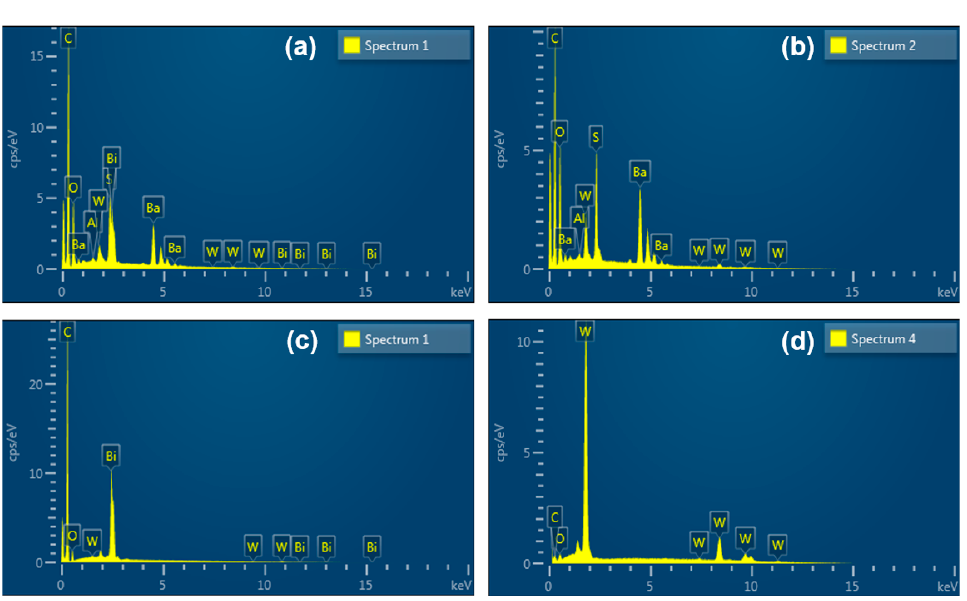
Figure 4. Component analysis results of the shield samples: ( a ) PWBaBi-80 (W, Ba, Bi), ( b ) PWBa-80 (W, Ba), ( c ) PWBi-80 (W, Bi), and ( d ) PW-85 (W).